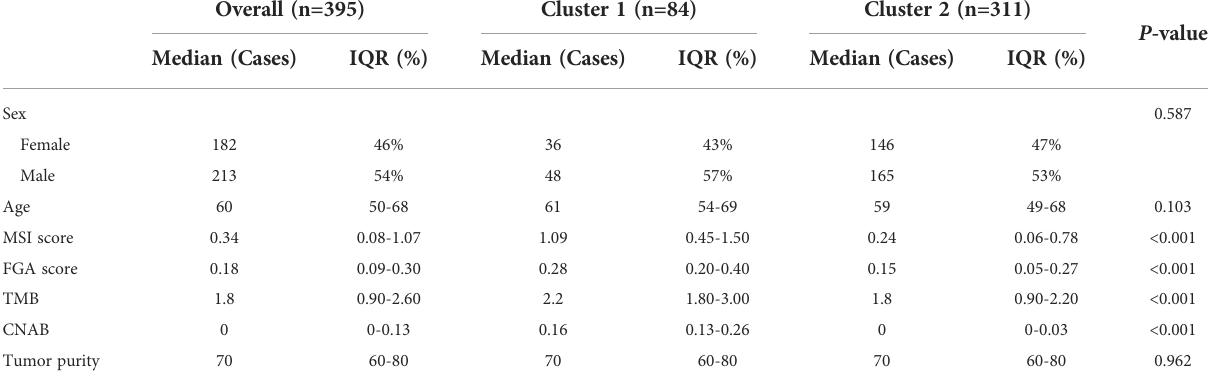
TABLE 1 Clinical characteristics and genomic